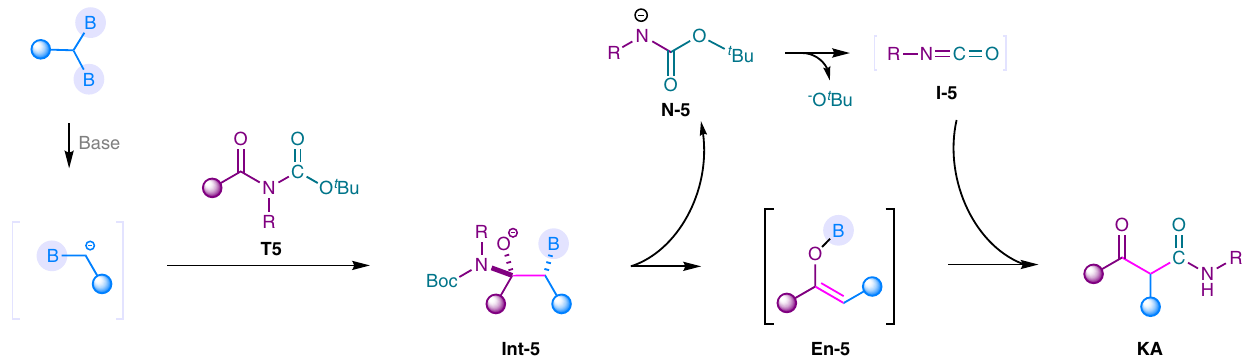
Fig. 6 Mechanistic hypothesis. Proposed pathway for the transformation of N -Boc